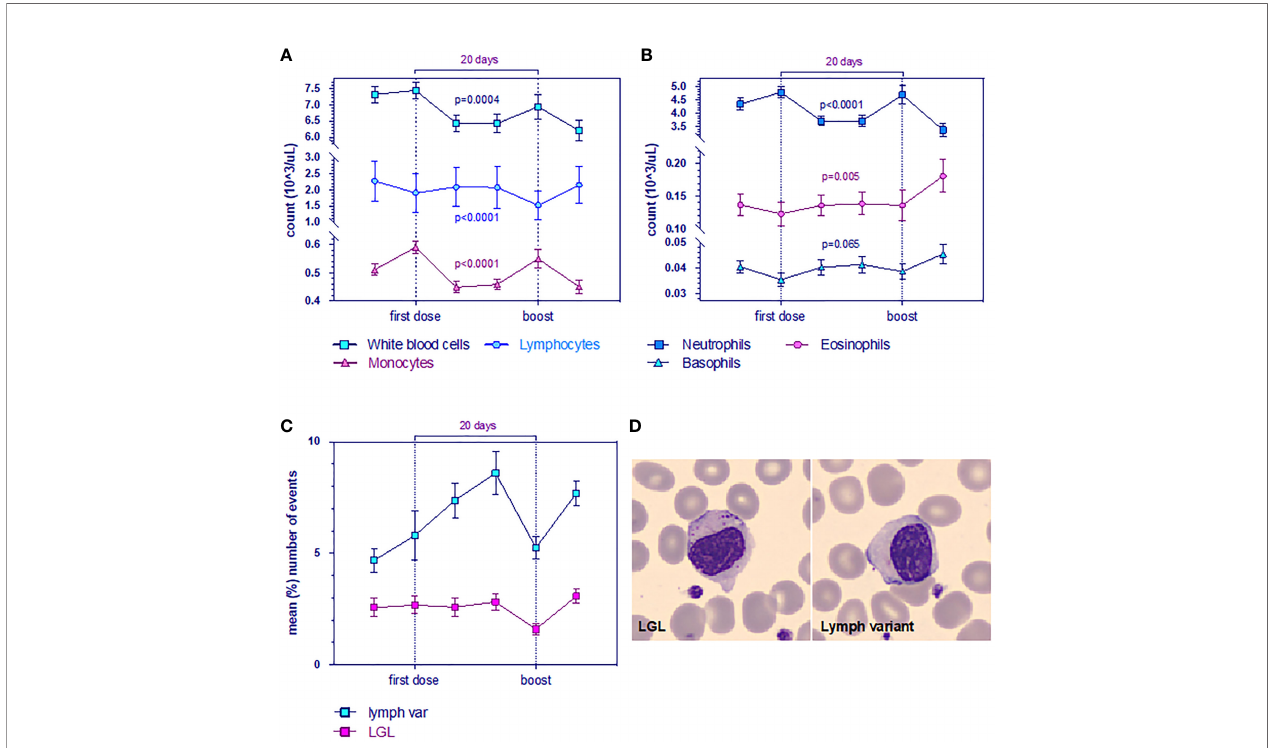
FIGURE 3 | Evolution of leukocyte levels (A) White blood cell (WBC, blue), lymphocyte (light blue) and monocyte counts are signi fi cantly reduced. Data are mean ± s.e.m. p-value for time from multivariable mixed-effect model for repeated measures. (B) Neutrophils (blue), eosinophils (purple), and basophils (light blue). Data are mean ± s.e.m. p-value for time from multivariable mixed-effect model for repeated measures. (C) Mean (%) number of events (n = 23 LGL, n = 34 lymphocyte variants) for large granular lymphocytes (LGL, purple) and for the variant form of lymphocytes. Wilcoxon test for pairing showed r = 0.8 (Spearman) and p = 0.03. (D) Morphological changes in whole blood smearing stand out low quantities of anomalous cells observed with CellaVision